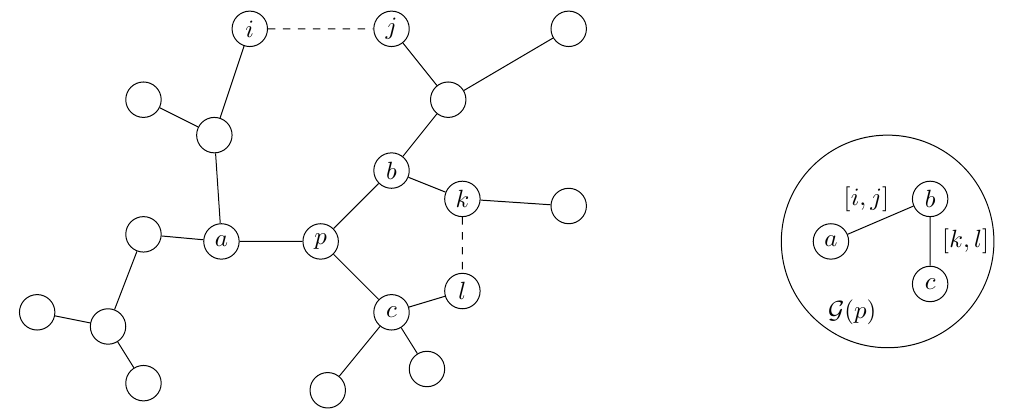
Figure 4 Left: the spanning tree T ∗ and two alternative edges (dashed). Right: two corresponding links [ a, b ] and [ b, c ] in the local subgraph G ( p